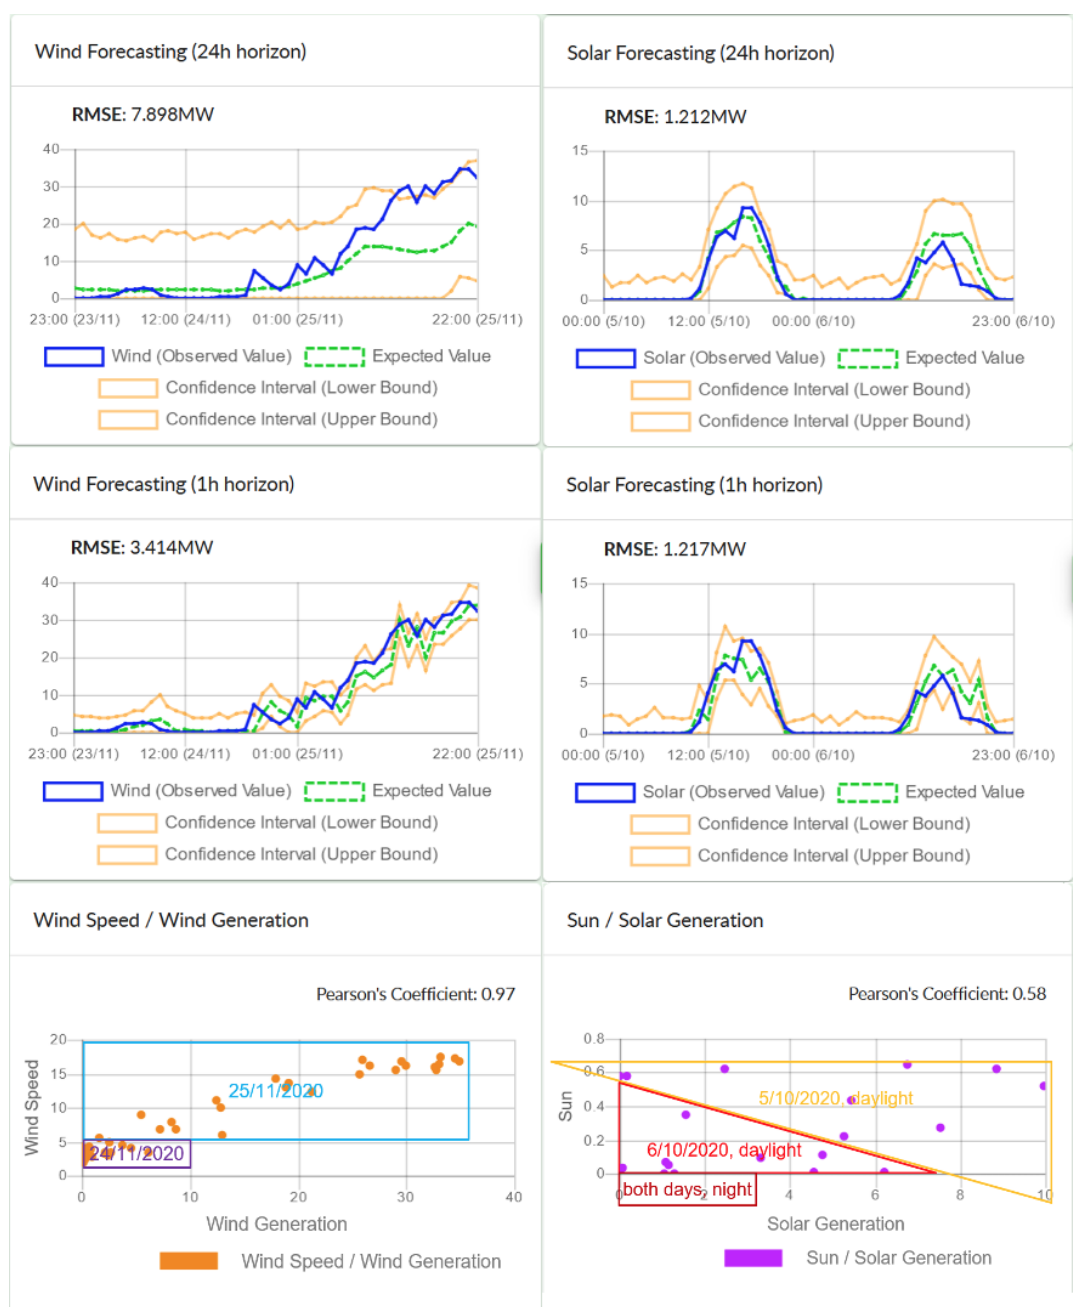
Figure 7. Examples showing the effect of wind speed and sun on Madeira wind ( left ) and solar ( right ) generation respectively [exact and forecast generation values with 95% confidence interval based on 24-h ( top ) and 1-h ( middle ) forecasting horizon], during 2 consecutive days of the same clustering group with different weather and generation profiles, as shown by the scatter plots ( bottom ). The measurement units of generation and wind speed are MW and mph respectively, and the time zone is 2 h ahead of